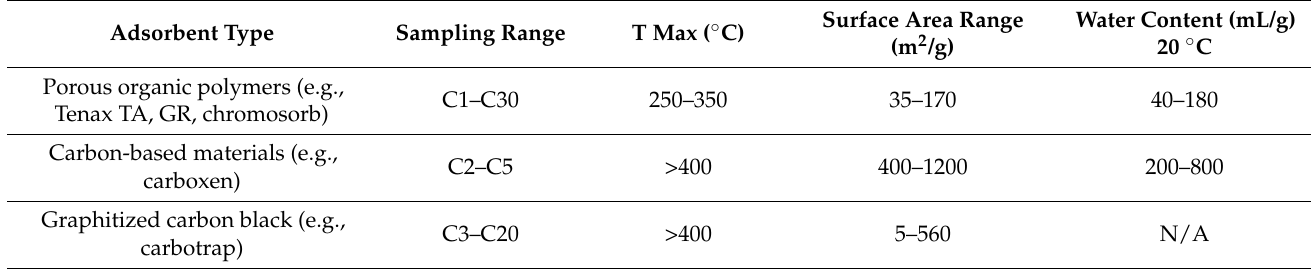
Table 4. Selected types of adsorbents and their properties.